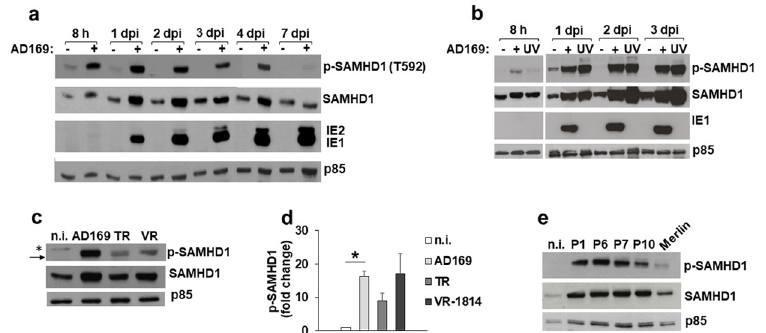
Fig 4. SAMHD1 is phosphorylated at T592 in HCMV-infected cells. a) SAMHD1 phosphorylation at T592 (pT592) was analyzed by immunoblotting with a specific antibody in cell lysates of HFFs not infected or infected with AD169 at an MOI of 1 for the indicated time points. Expression of IE1/IE2 viral antigens was used as control for infection, while p85 was the loading control. A representative experiment out of six is shown. b) pT592-SAMHD1 was analyzed as in panel a), in parallel with an UVB-inactivated AD169 (UV), for the indicated time points. A representative experiment out of two is shown. c) pT592-SAMHD1 was analyzed as in panel a), in HFFs not infected or infected with the indicated strains (MOI 1, 3 dpi). A representative experiment out of three is shown. d) The relative amount of pT592-SAMHD1, normalized to that of p85, was determined by densitometric analysis and is relative to that of n.i. cells, which was arbitrarily set as 1. Data are expressed as mean ± SE of at least three independent experiments. � , p < 0.05. e) pT592-SAMHD1 levels in HFFs infected with HCMV clinical isolates (P1, P6, P7 and P10) or with Merlin. Data derive from one representative experiment out of two. � , unspecific band; black arrow, pT592-SAMHD1 specific band.